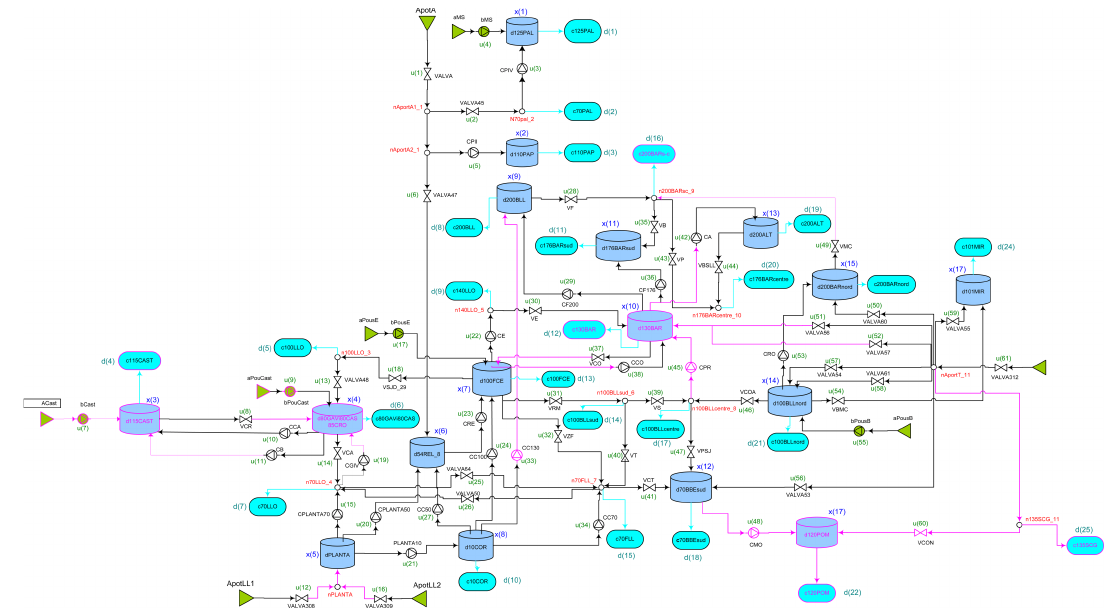
Figure 3. Aggregate case of the Barcelona Drinking Water